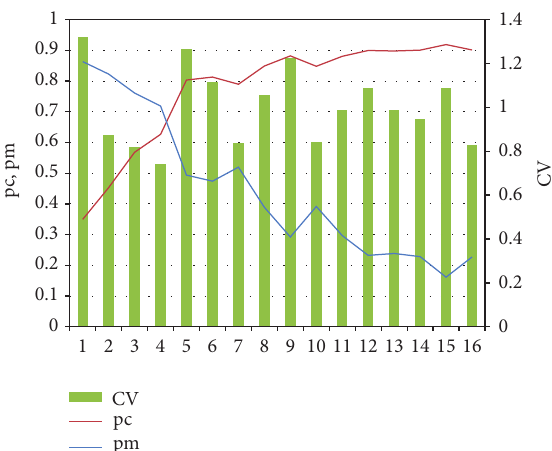
Figure 4: pc, pm, and CV graph over the